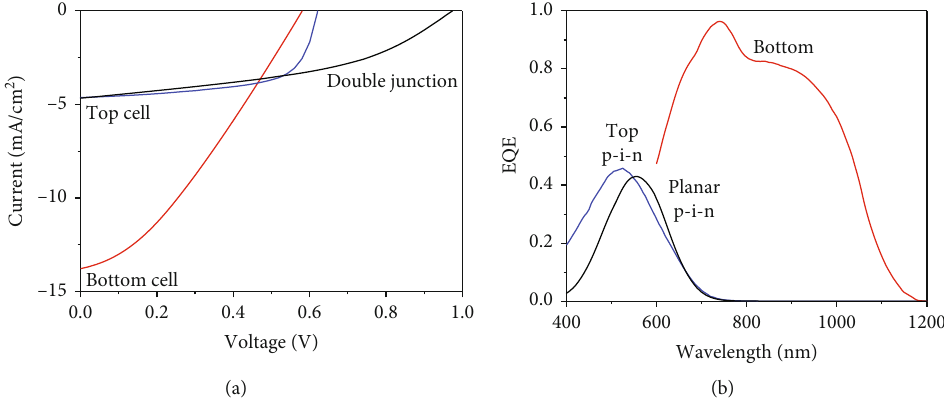
Figure 11: Experimental I-V curves (a) and EQE spectra (b) for the tandem a-Si:H/c-Si test solar cell